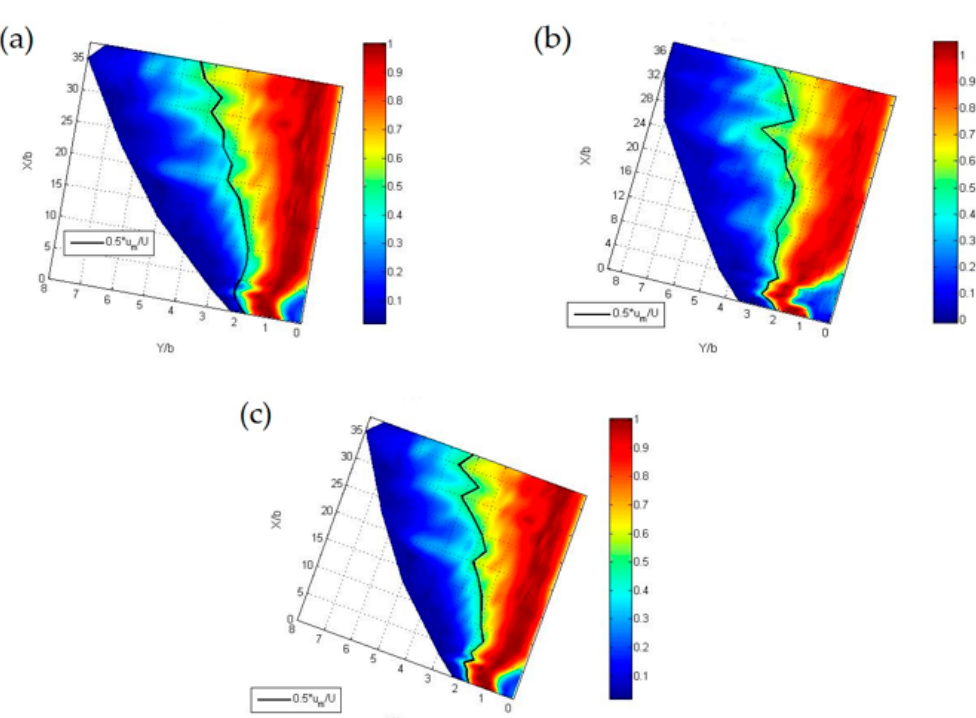
Figure 8. Ratio u / U (average velocity u to exit velocity U ) in: case (1) main nozzle (MN) only; case (2) MN and the auxiliary Figure 8. Ratio Uu / (average velocity u to exit velocity U ) in: case 1) main nozzle (MN) only; case 2) MN and the auxiliary nozzle (AN) operating in injection mode (MN + AN INJ); case 3) MN and the AN operating in suction mode nozzle (AN) operating in injection mode (MN + AN INJ); case (3) MN and the AN operating in suction mode (MN + AN (MN + AN SUC). SUC). Energies 2021 , 14 , x FOR PEER REVIEW